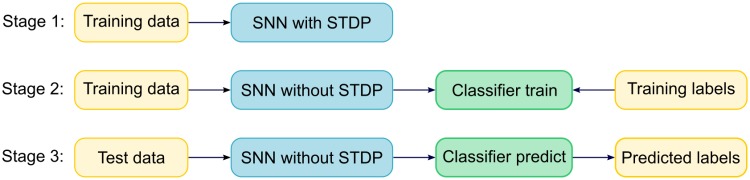
Three stages of model’s evaluation.Firstly, the SNN is trained with STDP on the training set without supervisory labels. Then the fixed network is run on the training set, and the output of the pooling layer and the corresponding labels in the training set, i.e. training labels, which are the corresponding labels of currently processed input samples, are used to train the classifier. Finally, the classifier is run to predict the labels of the test data, which are called as predicted labels. The classification accuracy of the model is evaluated by comparing the predicted labels with the corresponding ground truth labels.